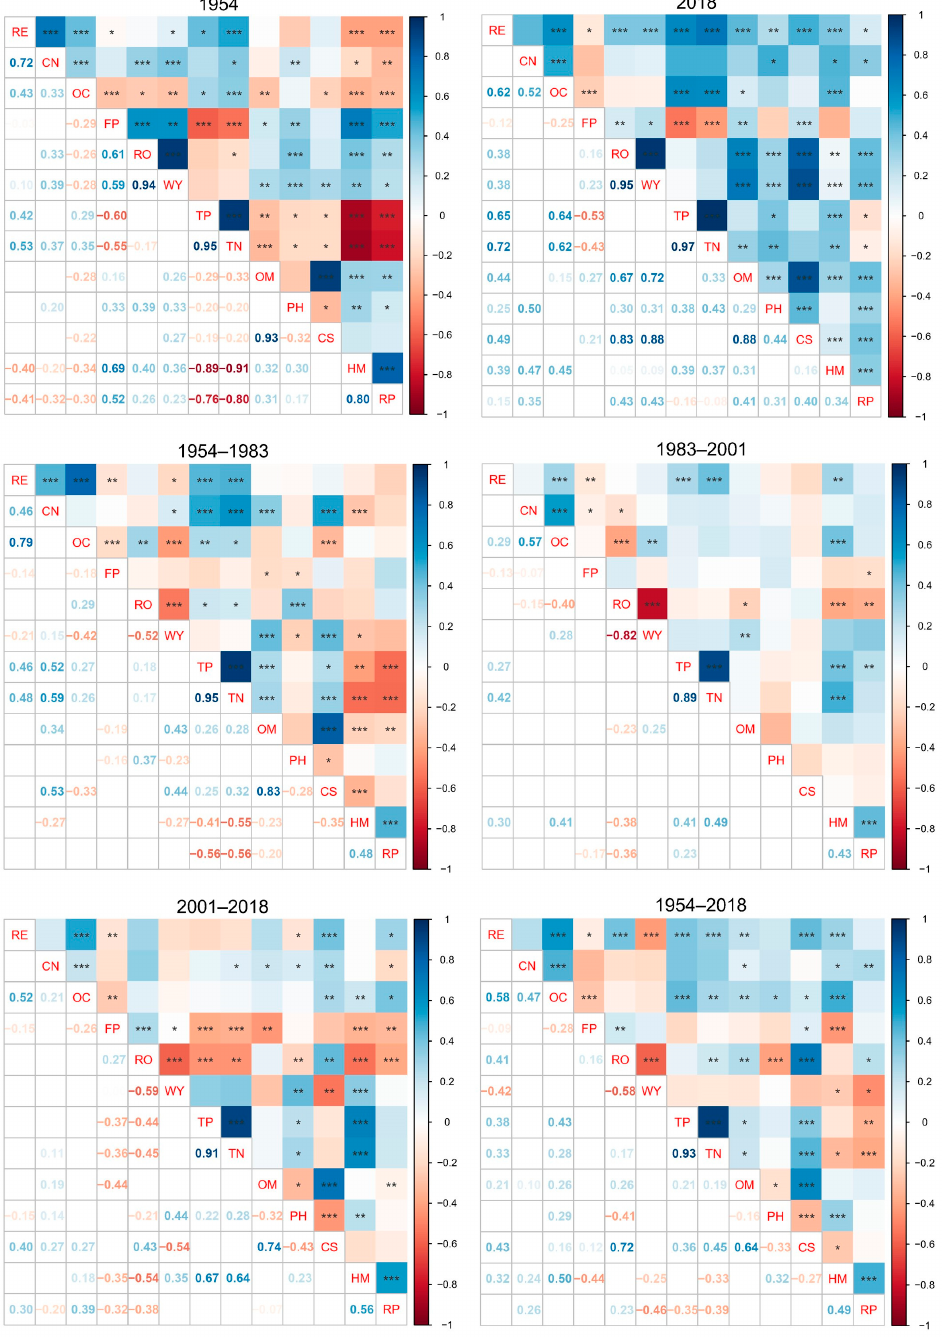
Figure 4. Snapshot correlations (1954, 2018) and change correlations (1954–1983, 1983–2001, 2001–2018, 1954–2018) between pairs of ES in Sihu agricultural watershed. The blue and red squares show the positive and negative correlations between ES. The asterisks in the squares show the significance degree (*** for p < 0.001, ** for p < 0.01, * for p < 0.05). The numbers indicate the Spearman’s correlation coefficients. RE: rice; CN: cotton; OC: oil crop; FP: freshwater products; WY: water yield; RO: